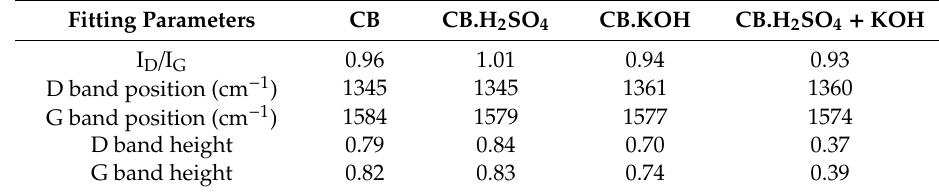
Table 3. Fitting parameters from Raman spectra of pyrolytic carbon black